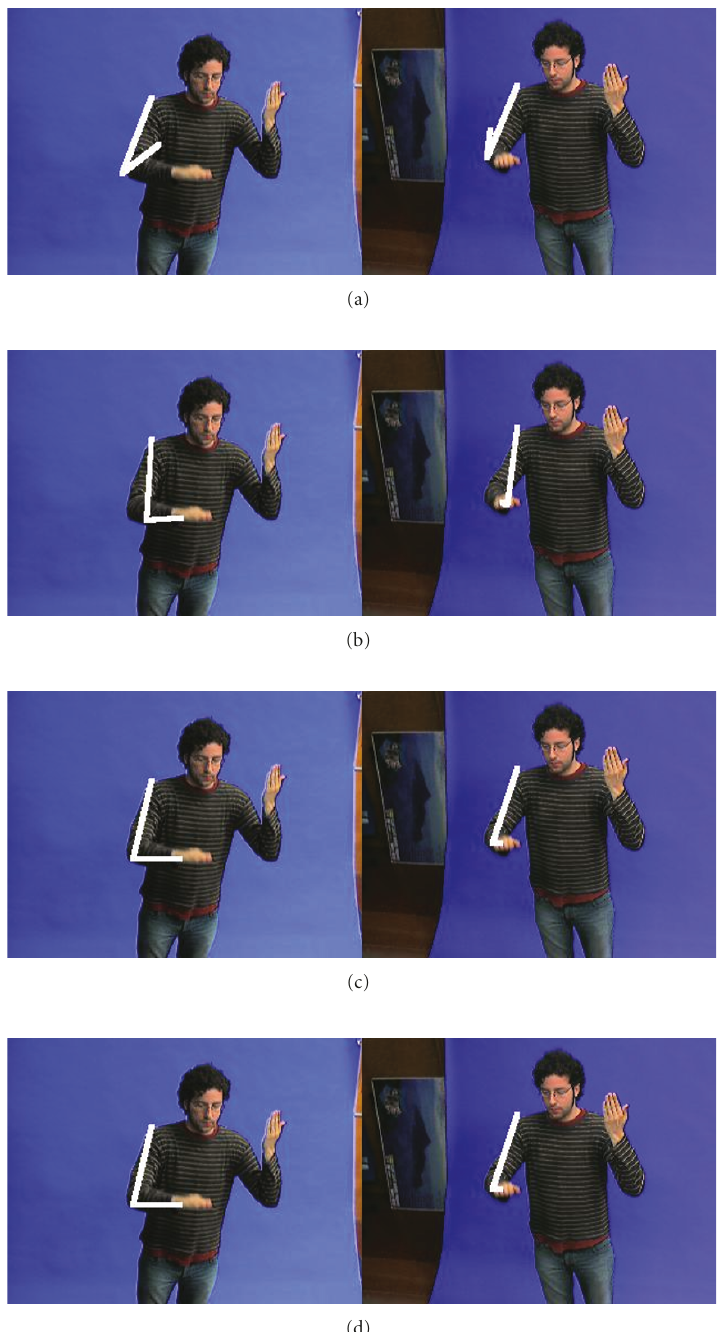
Figure 9: Working with real images. (a) Initial configuration of the articulated chain. (b) Arm estimation applying inverse kinematics approach. (c) And (d) arm estimation applying inverse kinematics with image constraints using one and two views